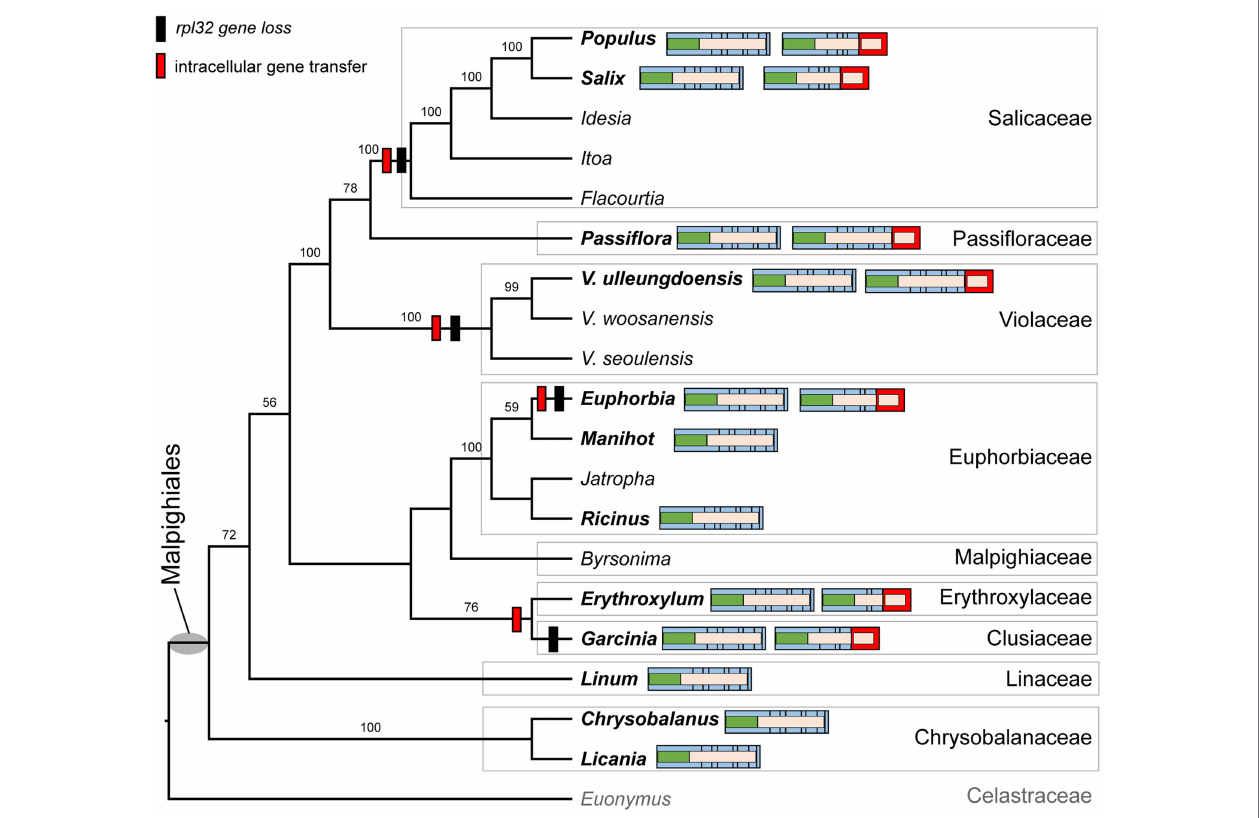
FIGURE 4 | Phylogenetic distribution of nuclear-encoded SODcp-RPL32 in Malpighiales. Phylogenetic relationships were inferred from 19 representative species in nine families of Malpighiales using an outgroup, Euonymus (Celastraceae). Bootstrap values based on 1,000 replicates and >50% are shown for each node. Schematic diagrams of the variable structure of the nuclear-encoded SODcp and SODcp-RPL32 genes among selected Malpighiales are shown for 12 taxa in bold. Colors correspond to transit peptides, exons, and conserved domains (see Figure 2